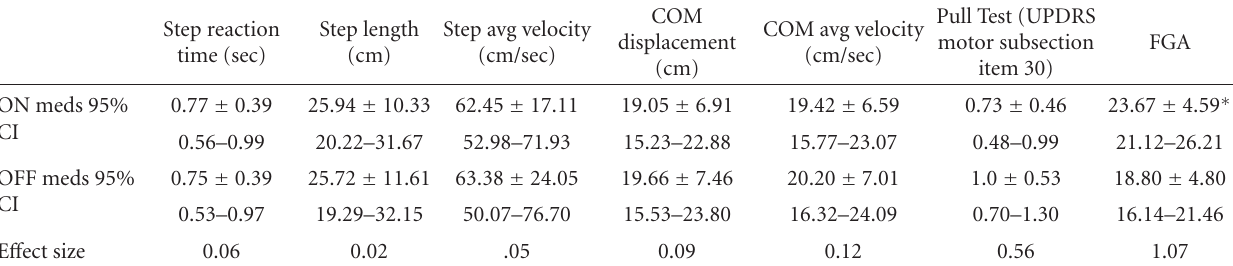
Table 1: Results of PD group ON and OFF medication (Mean ± SD).